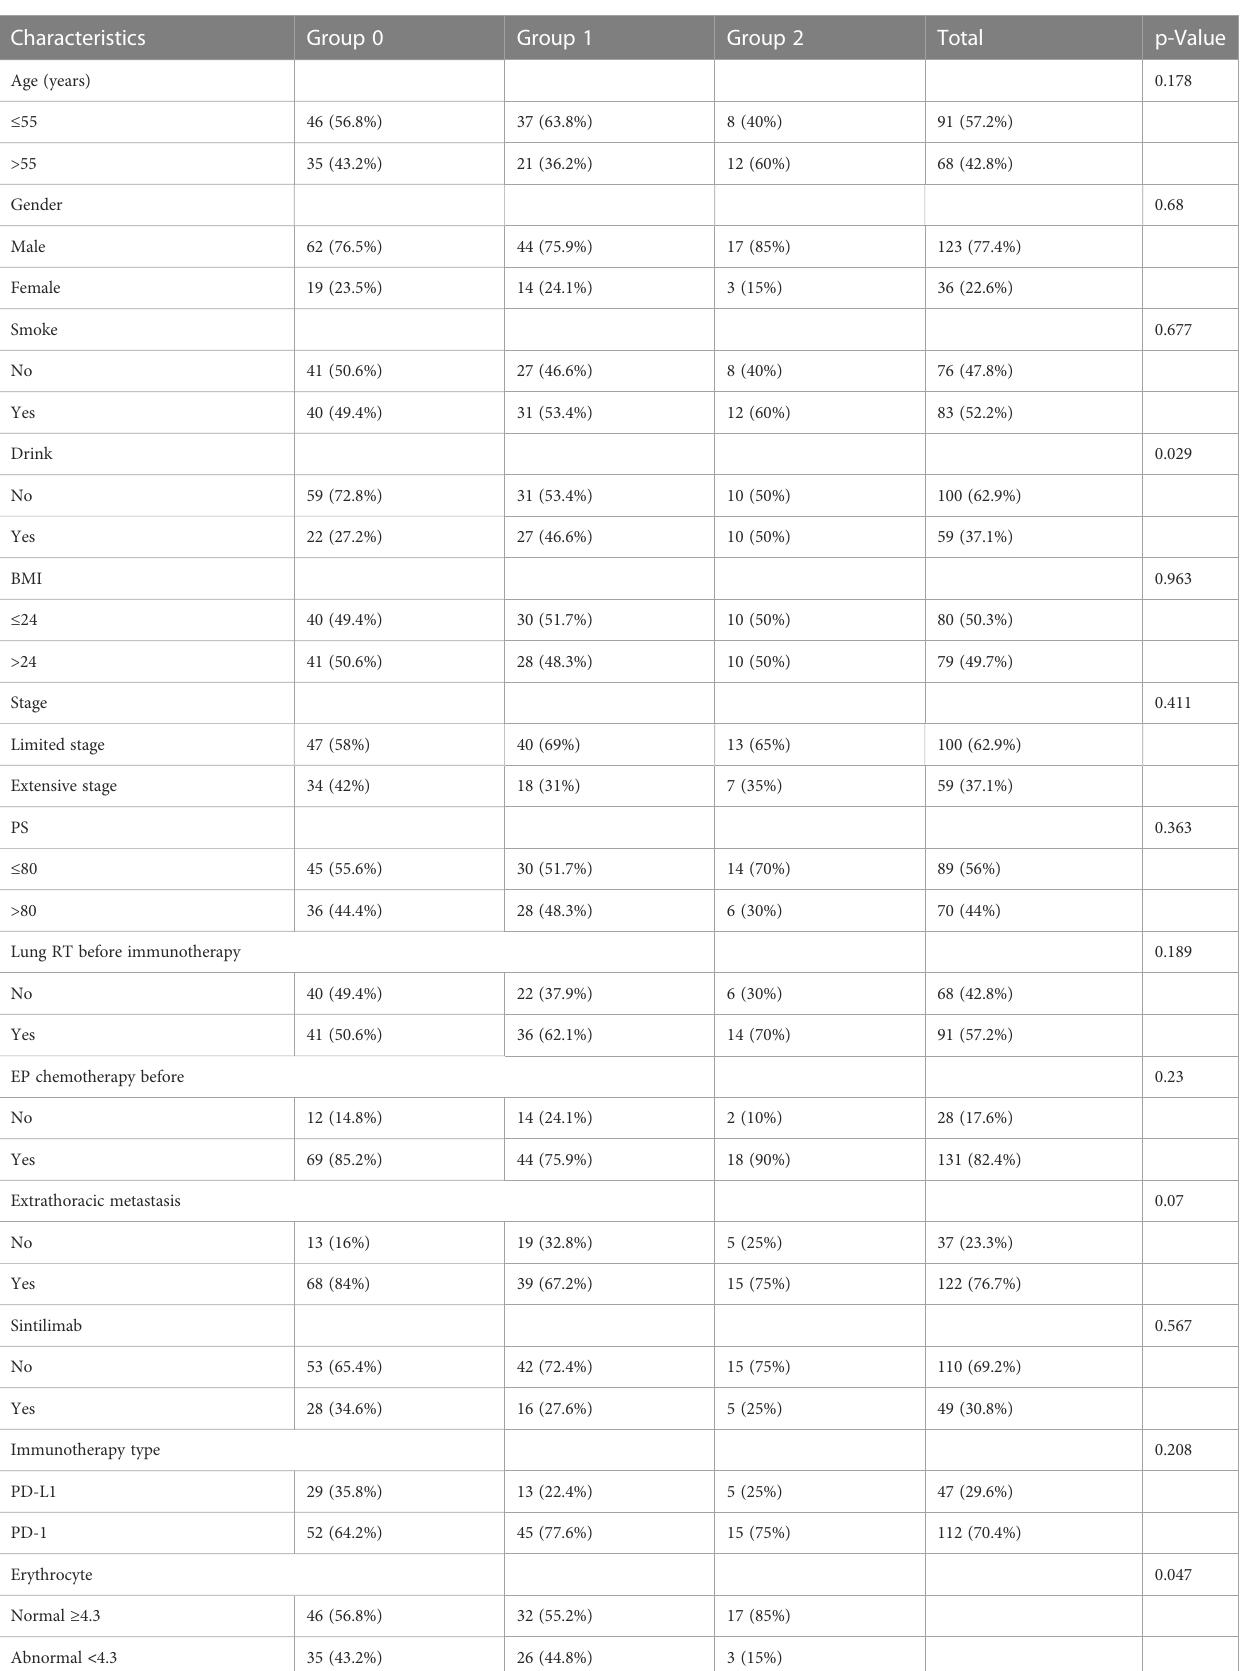
TABLE 1 Patient characteristics of the entire study cohort in three GRIm-Score